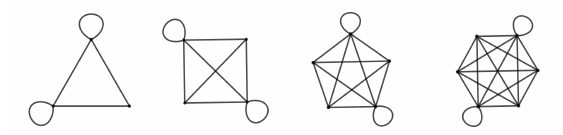
Figure 21. Maximum clique subgraphs for the cases of p equals two, three, four, and five distinct primes. The maximum clique subgraph is